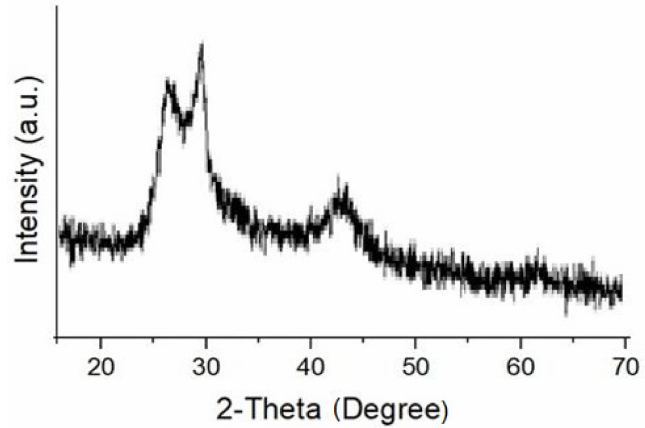
Figure 3. XRD spectra of MWCNT@celllulose nanocomposite showing degradation